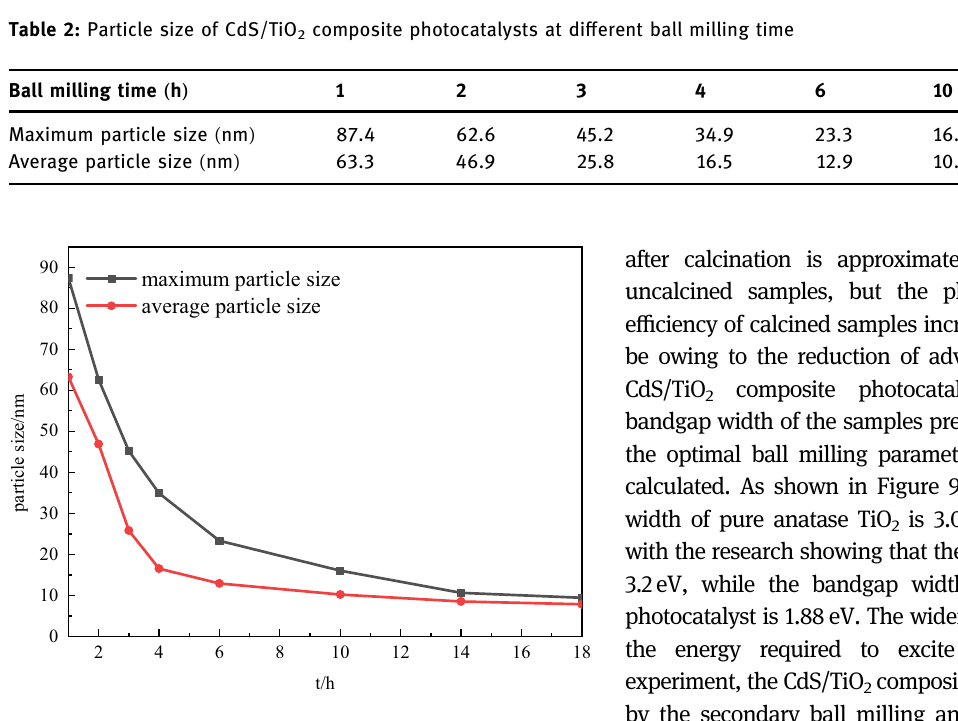
Figure 7: Particle size of CdS/TiO 2 composite photocatalysts at di ff erent ball milling time.